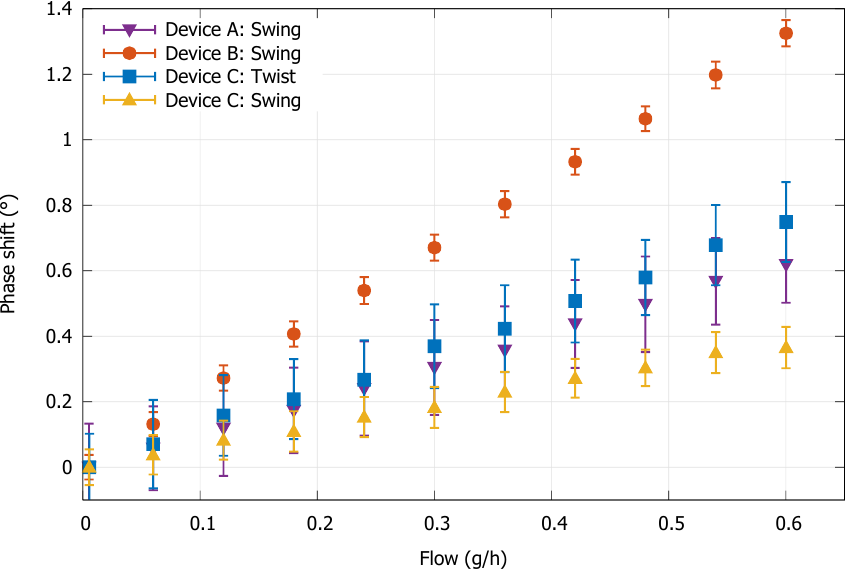
Figure 13. Output of the resistive readout in relation to the applied flow. Each shown measurement point is an average of the output signal over a period of 200 s at a stable flow. The error bars represent the standard deviation, which is determined over the same time